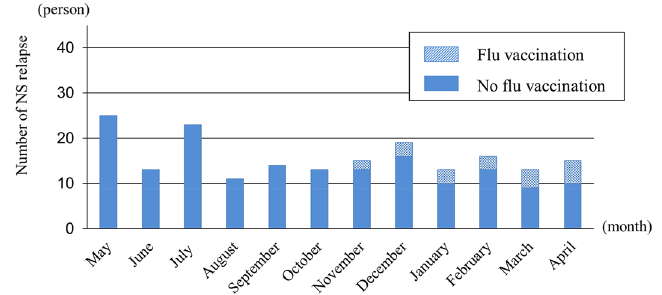
Figure 3. Number of nephrotic syndrome (NS) relapses. There was no seasonal distribution of NS relapse.